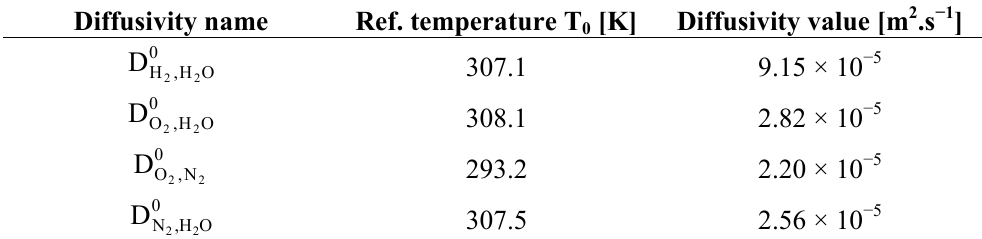
Table 2. Binary diffusivities at P 0 = 1 atm